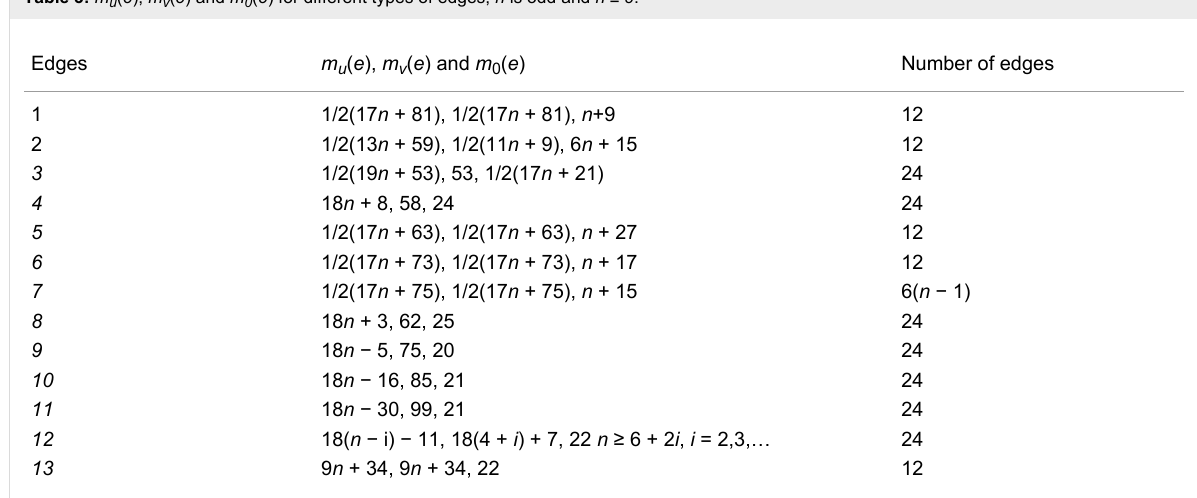
Table 3: m u ( e ), m v ( e ) and m 0 ( e ) for different types of edges, n is odd and n ≥ 9.